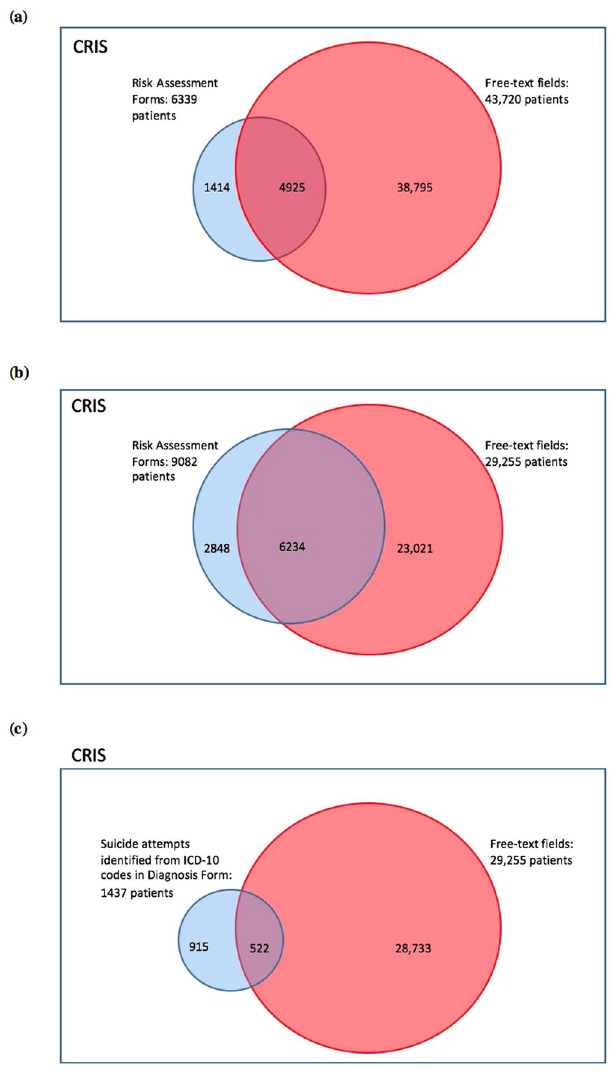
Figure 2. Venn diagrams comparing patient numbers obtained when ( a ) using NLP to identify suicide ideation versus using Risk Assessment (structured) fields only; ( b ) using NLP to identify suicide attempts versus using Risk Assessment (structured) fields only and ( c ) using NLP to identify suicide attempt versus using ICD-10 codes for suicide attempt